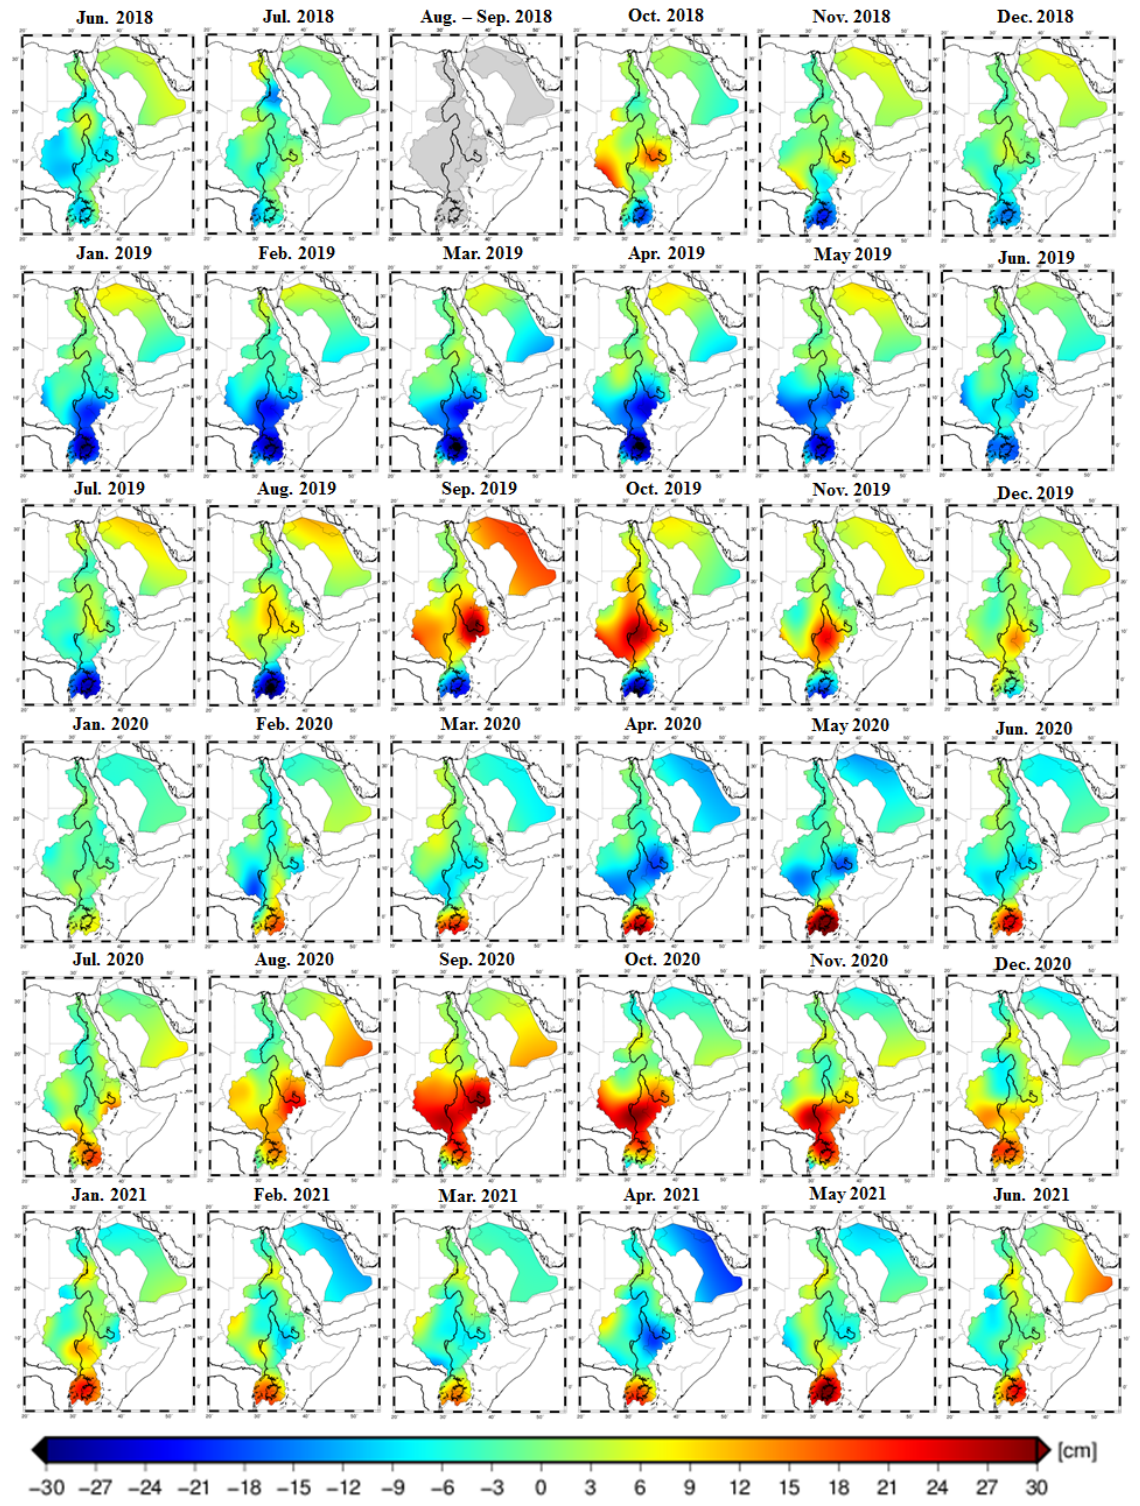
Figure 5. Mass variations in the TWS in terms of EWH [in cm] over the NRB and the MAS as derived from the DDK5 of GRACE-FO (RL06) products from the CSR official data center.